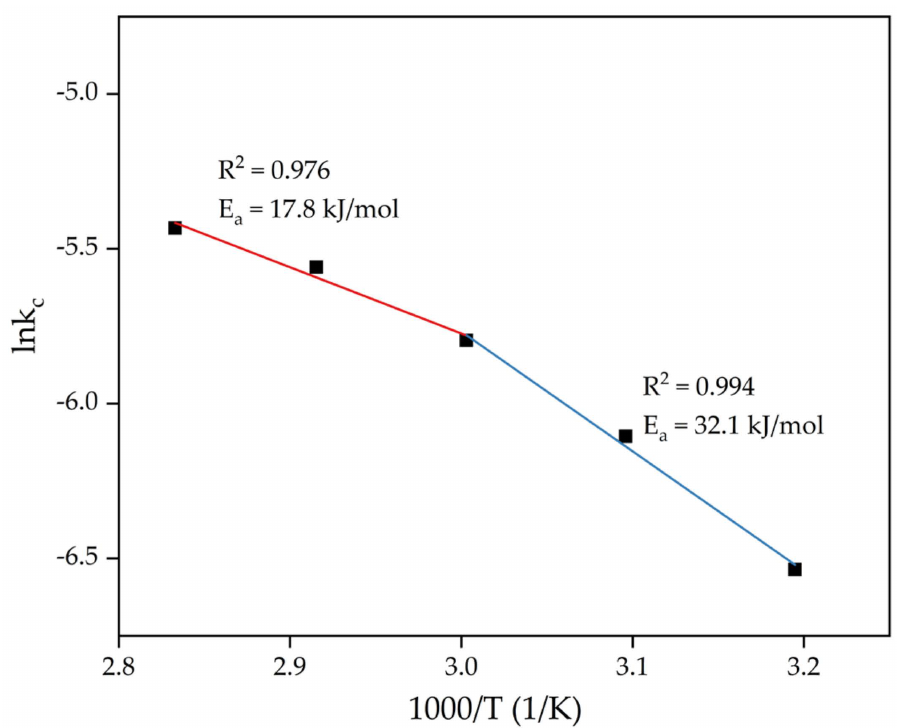
Figure 6. The dependence of lnk c on inverse temperature